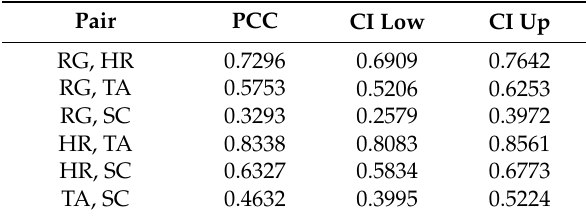
Table 1. Pearson’s correlation coefficient (PCC) between processed stress markers and the corresponding lower (CI low) and upper (CI up) bounds for a 95% confidence interval (CI). RG—relative gamma; HR—average heart rate; TA—trapezius activity; SC—skin conductance.